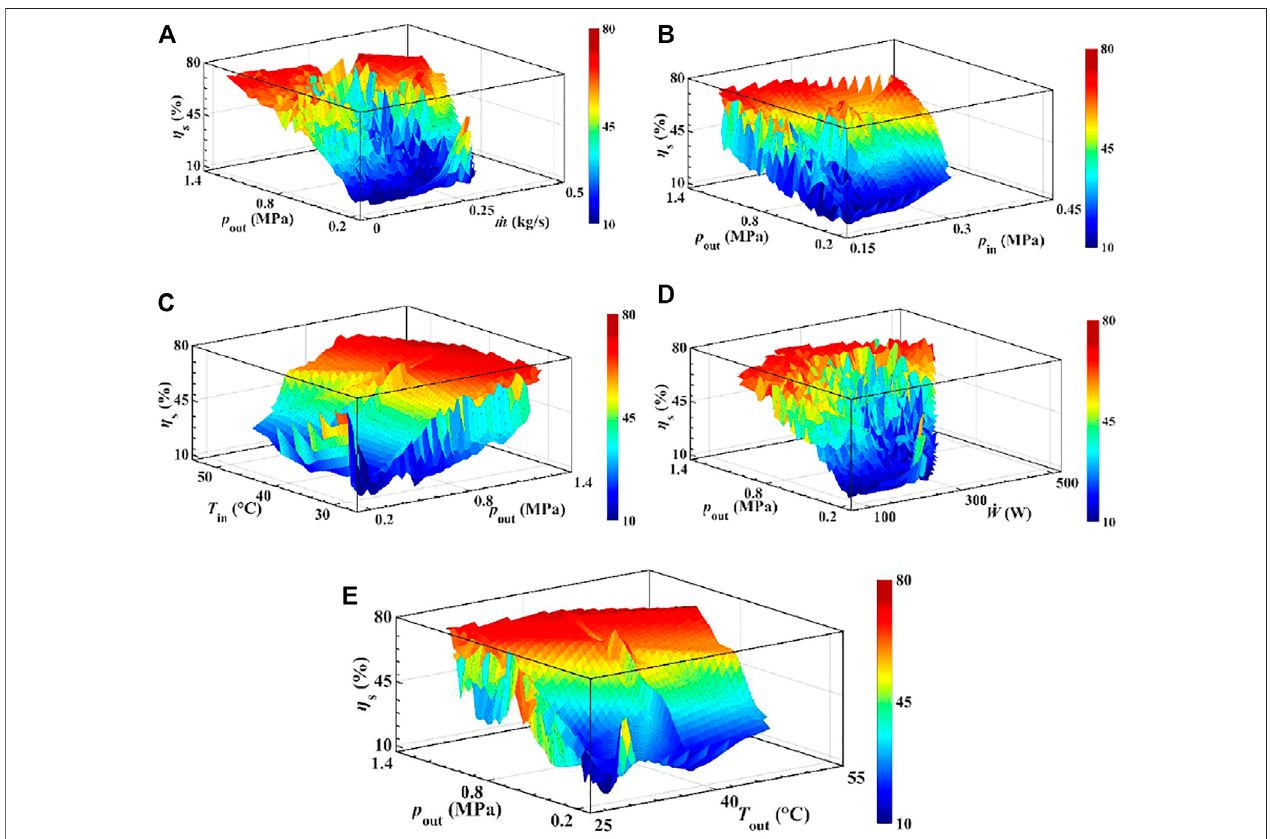
FIGURE 4 | Change trend of pump